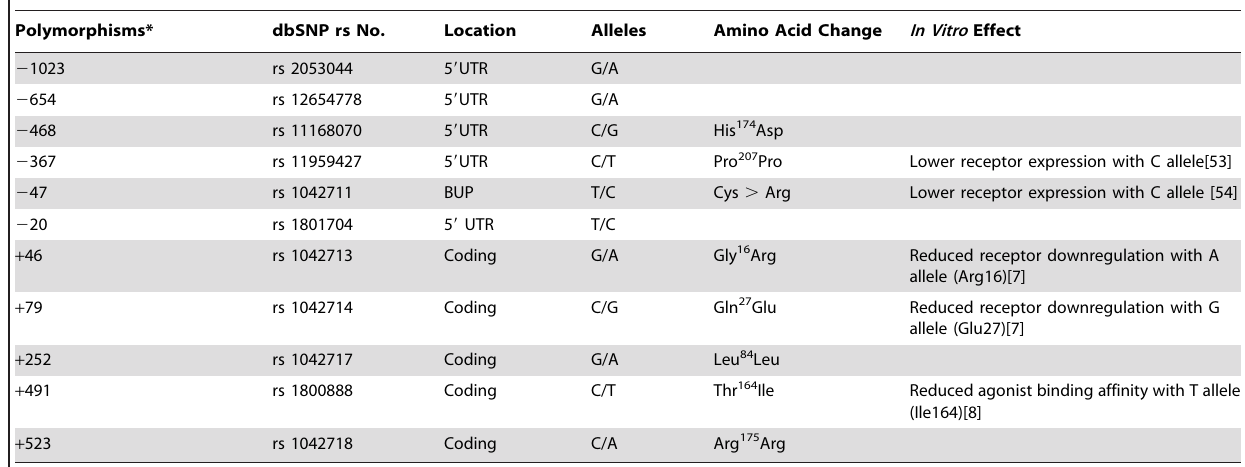
Table 1. ADR b 2 Polymorphisms Genotyped. 1